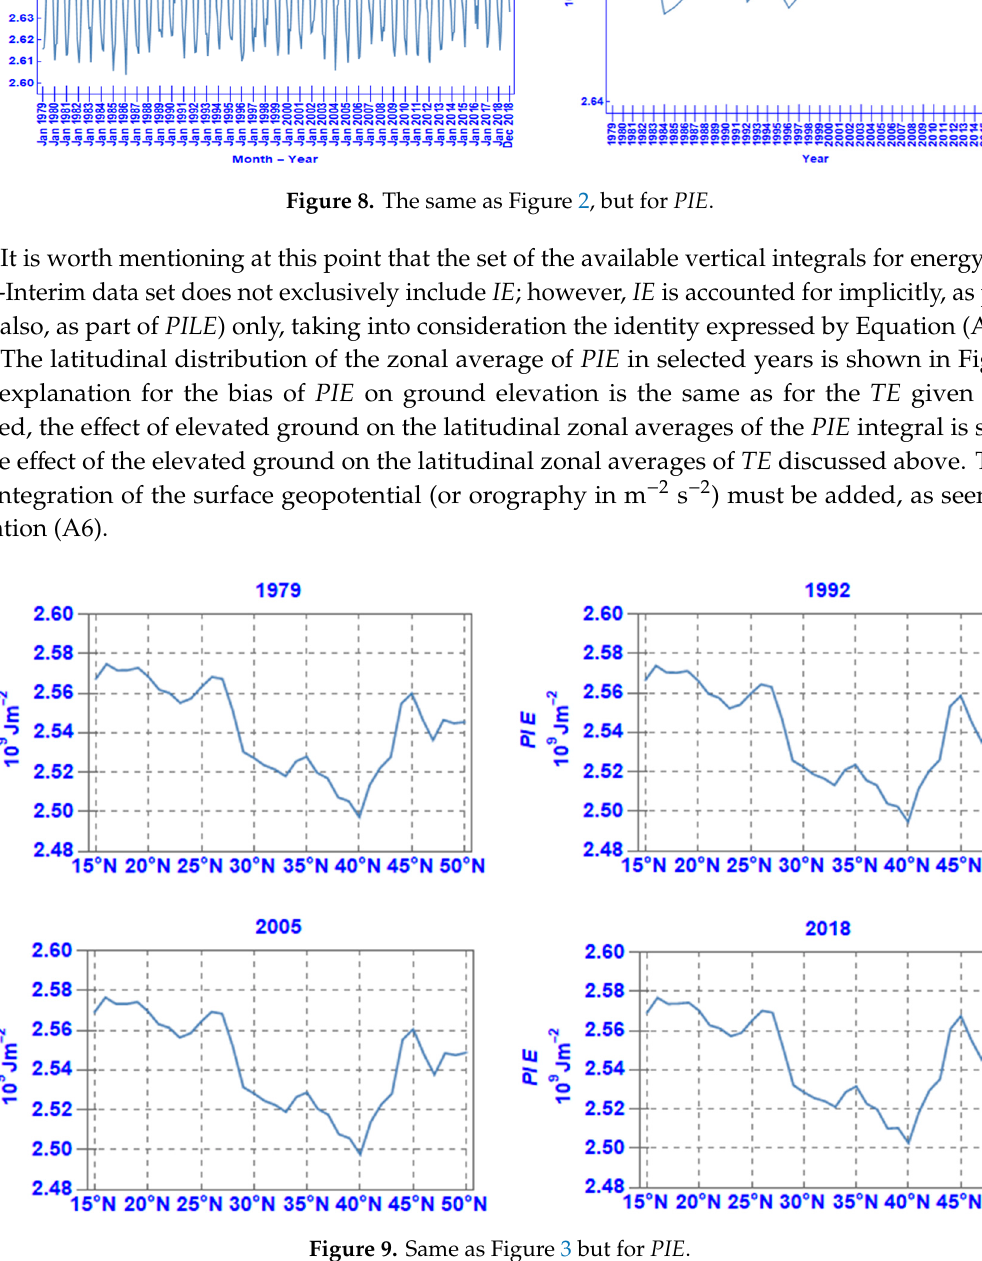
Figure 9. Same as Figure 3 but for PIE .